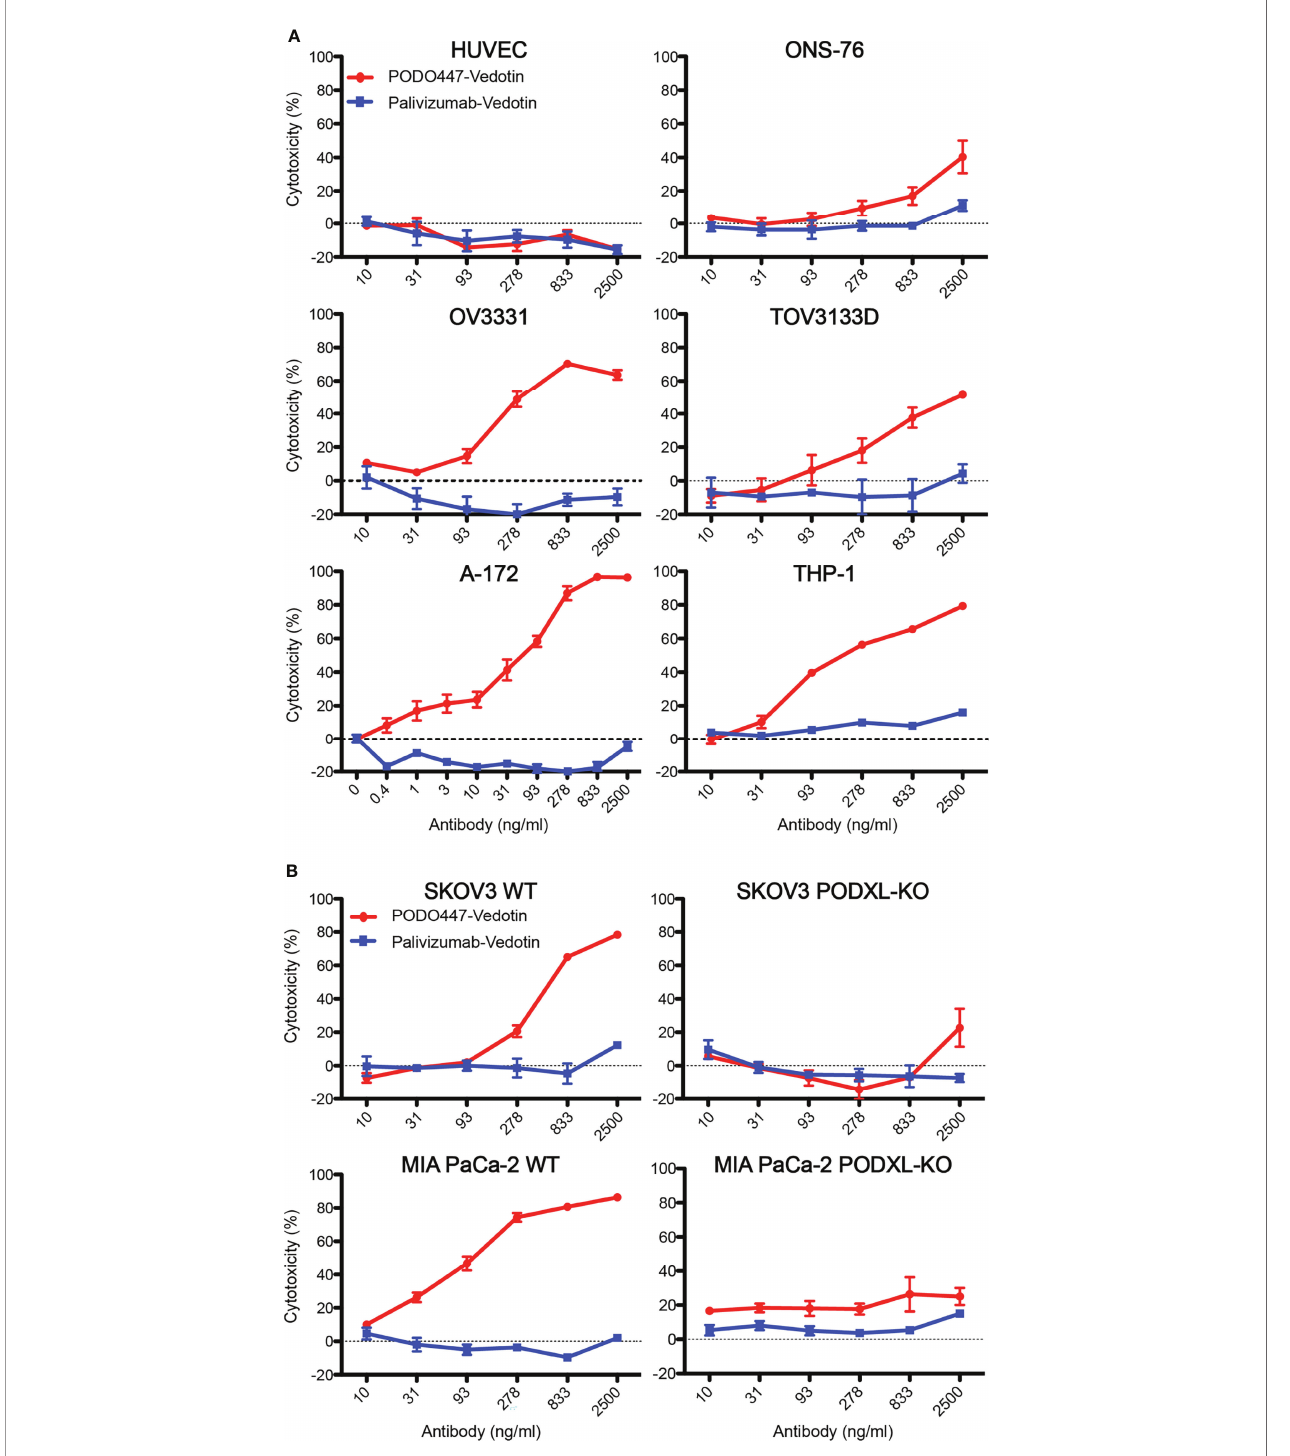
FIGURE 4 | In vitro cytotoxicity and selectivity of PODO447-Vedotin. Cytotoxic effect of PODO447- and palivizumab-Vedotin conjugates on (A) HUVEC (ns), ONS- 76 ( P < 0.001), OV3331 ( P < 0.001), TOV3133D ( P < 0.001), A-172 ( P < 0.001), THP-1 ( P < 0.001) and (B) SKOV3 ( P < 0.001) and MIA PaCa-2 ( P < 0.001) WT and PODXL-KO (ns) cells. Cells were assessed for viability by MTT assay after 144 h of continuous exposure. Horizontal line at 0% cytotoxicity is representative of untreated parental growth